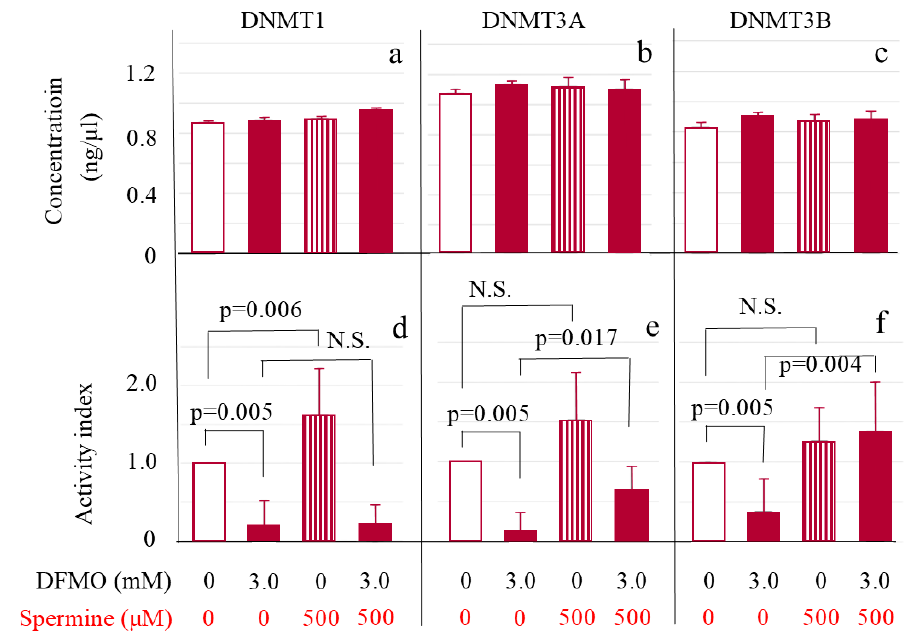
Figure 5. ODC inhibition suppressed DNMT 1, 3a, and 3b activities and spermine supplementation activated DNMT 3a and 3b without affecting their protein levels in Jurkat cells. Upper Figure: amount of DNMT subtypes. Nuclear proteins were extracted using 1.0 µ L of extraction buffer per 1.0 × 10 6 Jurkat cells and each DNMT enzyme concentration in extracts was determined. ( a ): DNMT 1; ( b ): DNMT 3A; ( c ): DNMT 3b. Lower Figure: Enzyme activity per amount of each DNMT subtype. Activity was determined after adjustment to make DNMT protein concentrations equivalent. DNMT activities are shown using indexes that were calculated by dividing the measured activity by that of the control culture for each subtype. ( d ): DNMT 1; ( e ): DNMT 3A; ( f ): DNMT 3b. Data are shown as means and standard deviations of six samples ( n = 6) in each culture condition. N.S.: not